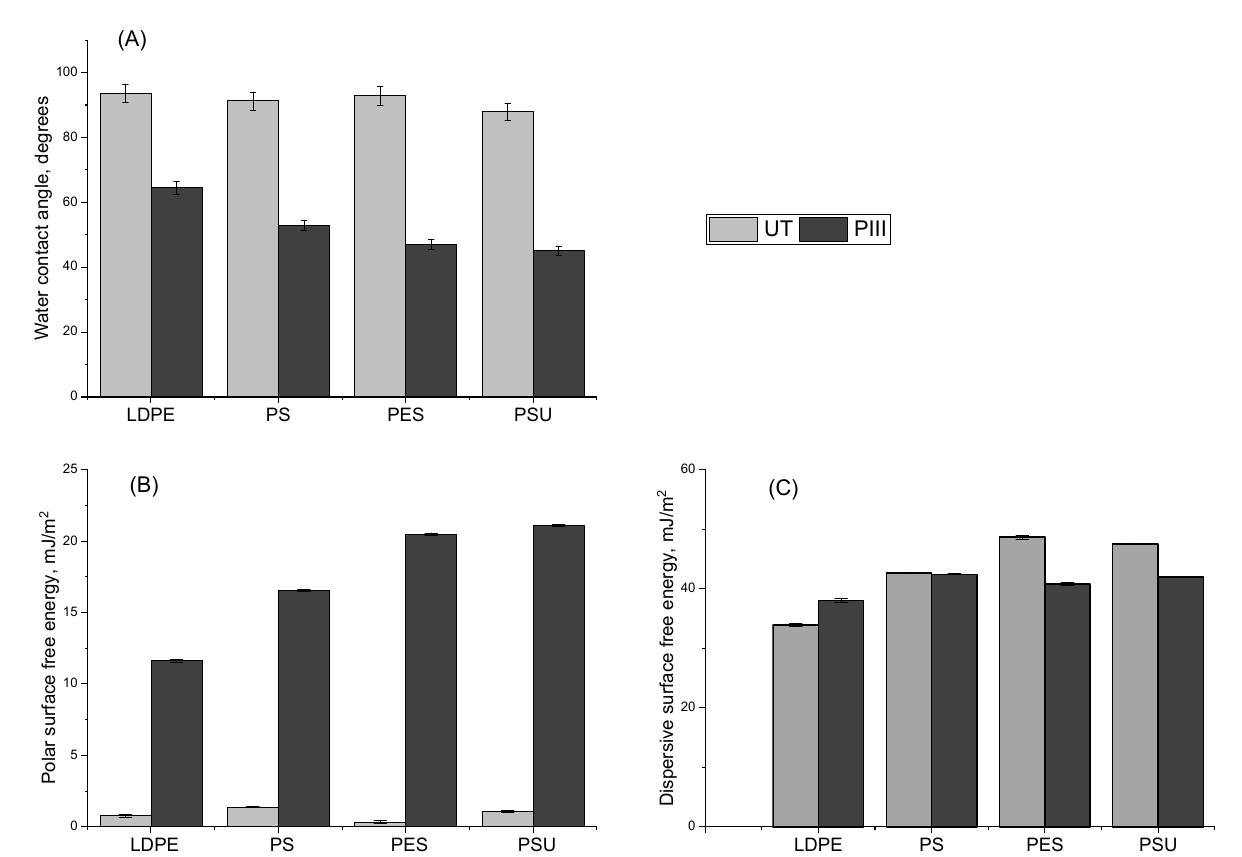
Figure 2. Comparison of surface wettability and energy between polymers before and after the PIII treatment. ( A ) Contact angle measurement of water, ( B ) polar surface energy and ( C ) dispersive surface energy. Light grey and dark grey denote untreated samples (UT) and PIII-treated samples (PIII), respectively. Error bars are standard deviation with n = 5.